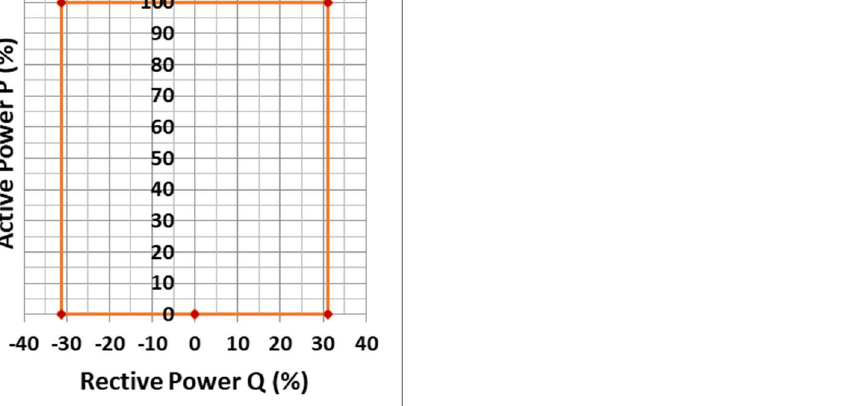
Figure 3. P-Q capability chart for large scale renewable power plants [4,26,27]. (Reprinted with permission from ref. [4]. Copyright 2021 IEEE).